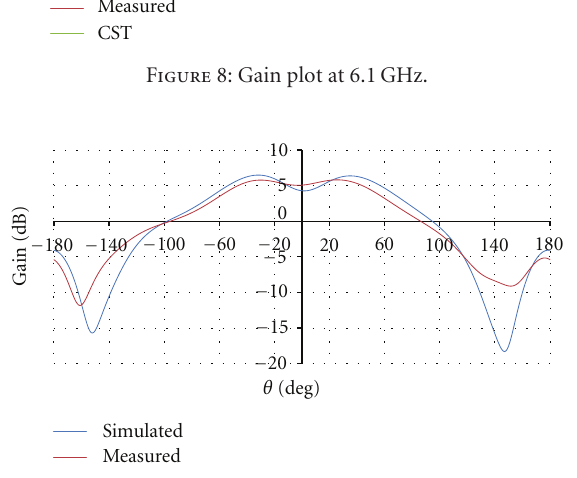
Figure 9: Gain plot at 8.33 GHz.